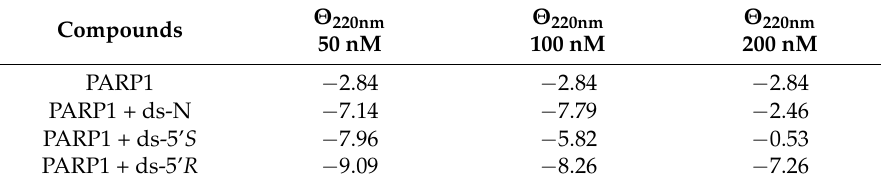
Table 3. Ellipticity values were converted into molar ellipticity Θ (deg · cm 2 · nmol − 1 ) based on the molecular weight of PARP1 proteins, of human PARP1 alone and along with increasing concentrations (50 nM, 100 nM, 200 nM), of double stranded oligonucleotides (ds-N, ds-5’ S -cdA, ds-5’ R -cdA), respectively, at 220 nm. The results are illustrated as mean values of triplicate with errors ± 5%.